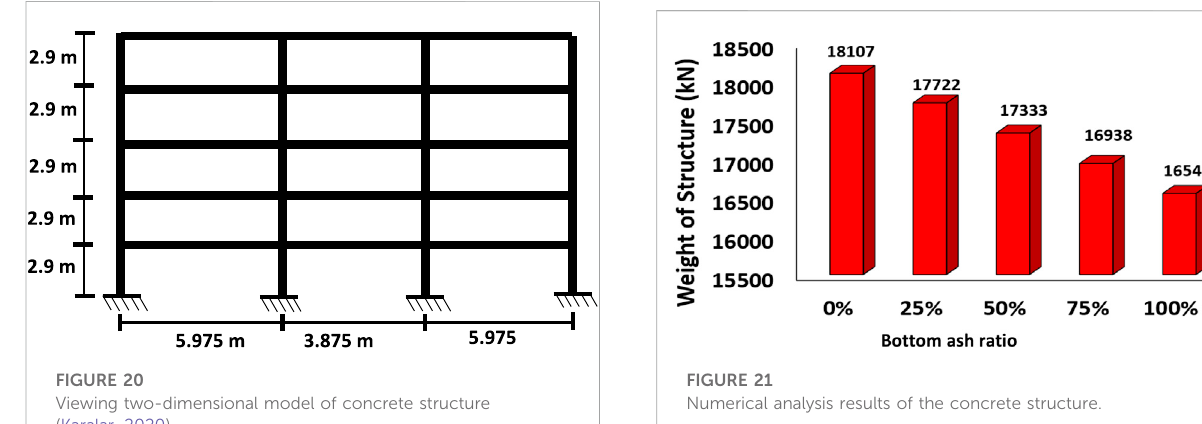
FIGURE 20 Viewing two-dimensional model of concrete structure (Karalar, 2020).